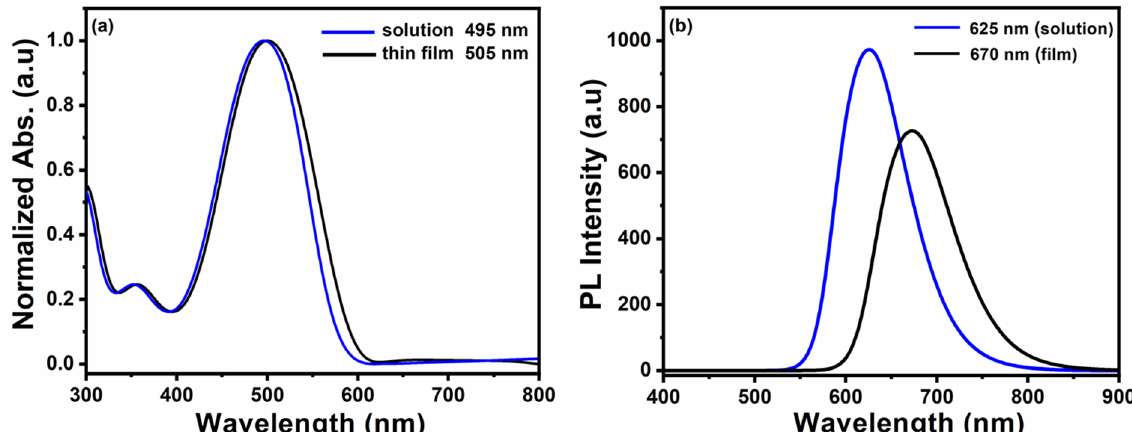
Table 1. Optical and electrochemical values of H3T-4-FOP SOM.